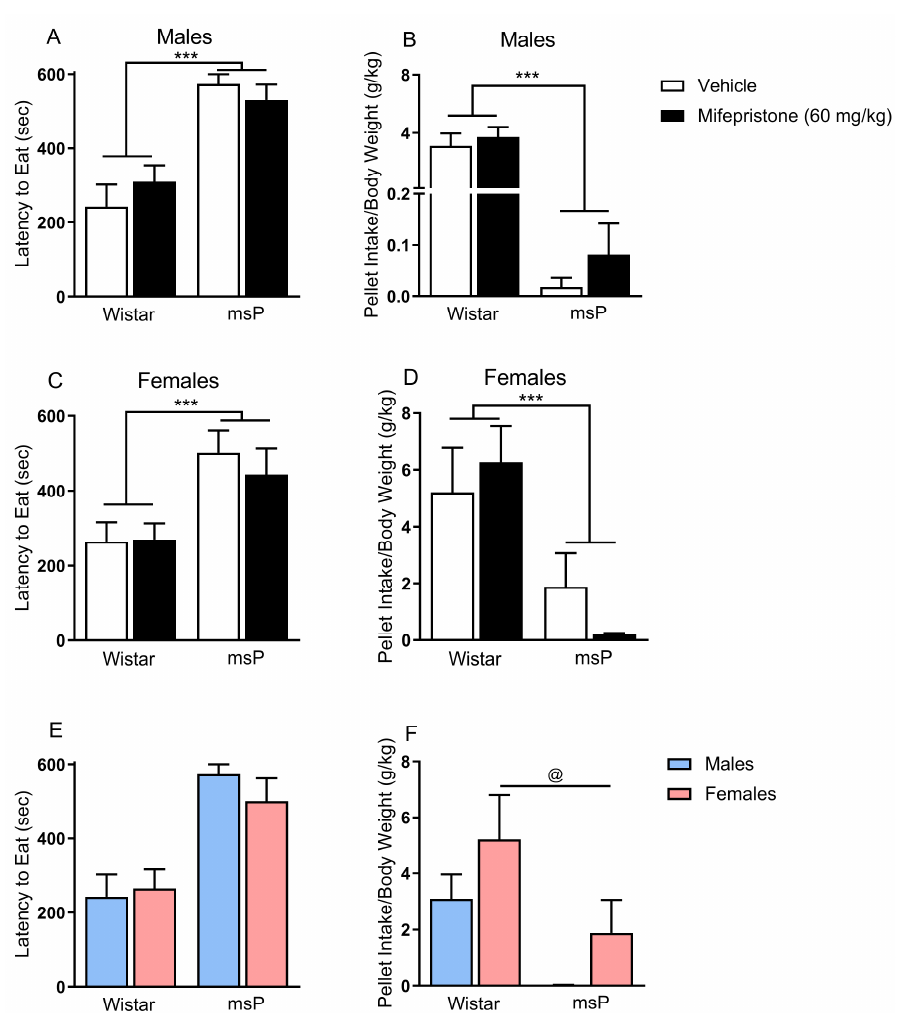
Figure 1. Effect of glucocorticoid receptor (GR) antagonist mifepristone on novelty-induced hypophagia (NIH) in both male and female Wistar and msP rats. Mifepristone (60 mg/kg) was injected intraperitoneally, and rats were subjected to the NIH test after 90 min. Male and female msP rats displayed higher anxiety-like behavior during NIH that was not reduced by mifepristone. ( A ) latency to eat chocolate pellets, ( B ) pellet intake in vehicle ( n = 9) or mifepristone-treated ( n = 10) male Wistar rats and vehicle ( n = 13) or mifepristone-treated ( n = 12) male msP rats. ( C ) latency to eat chocolate pellets, ( D ) pellet intake in vehicle ( n = 9) or mifepristone-treated ( n = 9) female Wistar rats and vehicle ( n = 8) or mifepristone-treated ( n = 10) female msP rats. ( E ) latency to eat chocolate pellets, ( F ) pellet intake in male Wistar ( n = 9) and male msP ( n = 13) rats, female Wistar ( n = 9) and female msP ( n = 8) rats. Results are expressed as mean ± SEM. Two-way ANOVA followed by Fisher’s LSD protected post hoc tests when an interaction between variables occurred. Main effect of genotype, *** p ≤ 0.001. Main effect of sex, @ p ≤